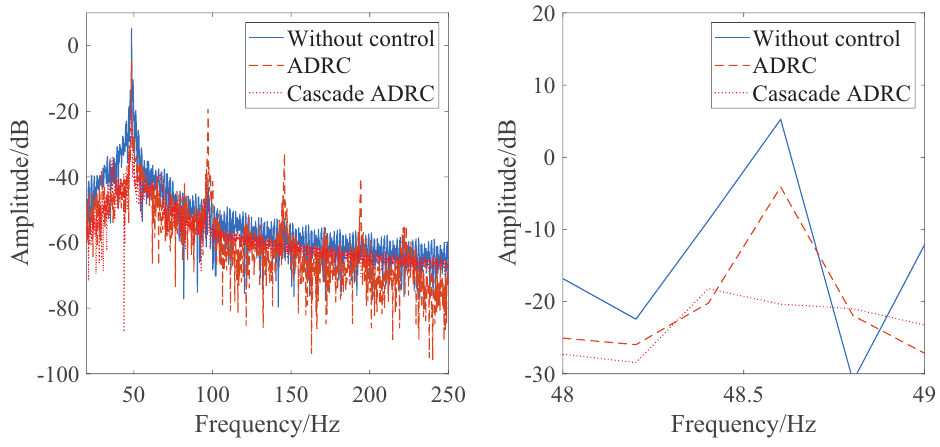
Figure 7. Control performance in frequency domain: globe–response curves and local–response